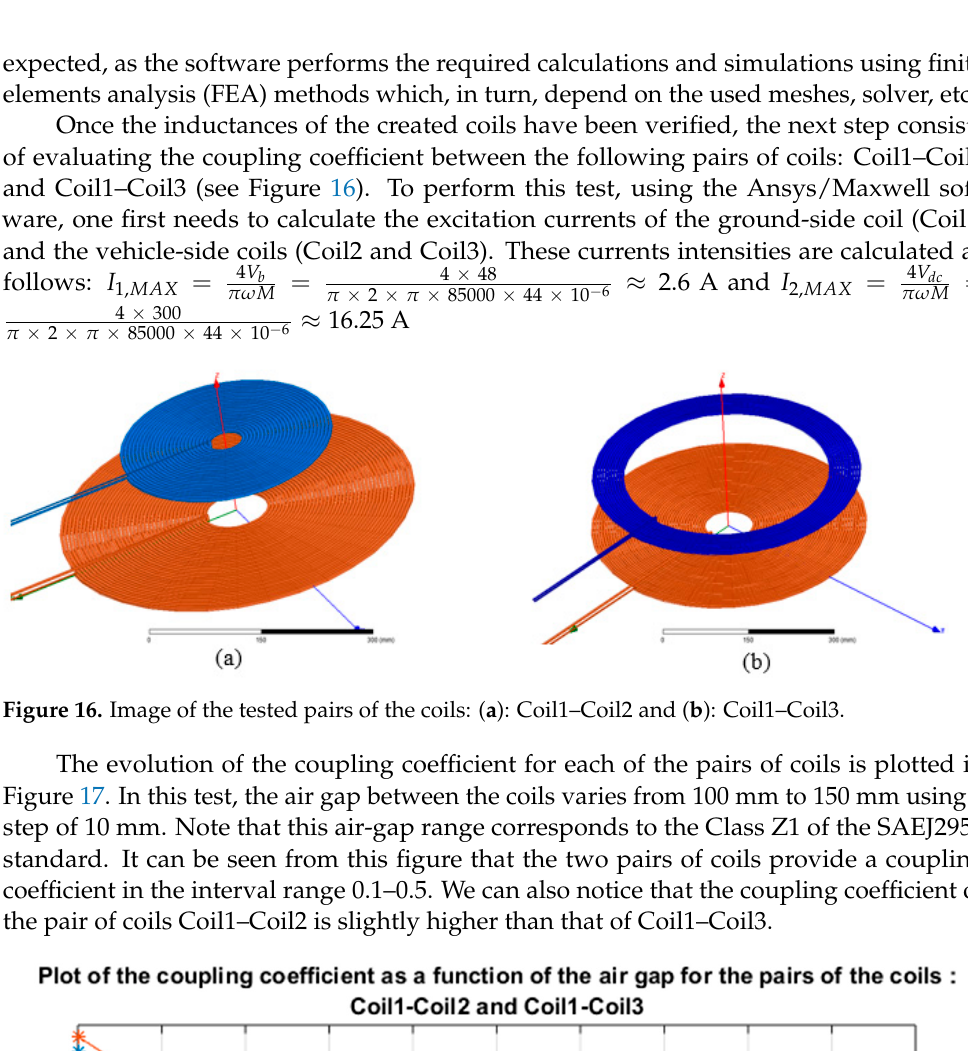
Figure 18. Magnetic field distribution of the pair of coils Coil1–Coil3.